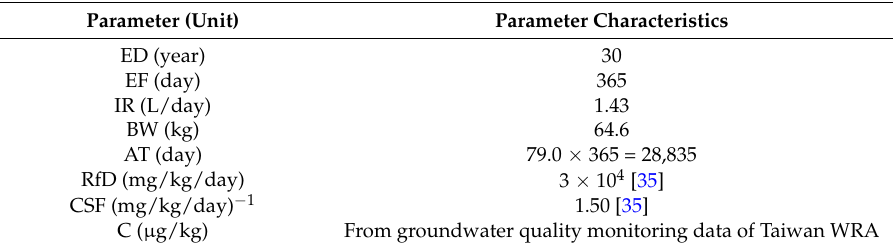
Table 1. Parameters used in the health risk model.